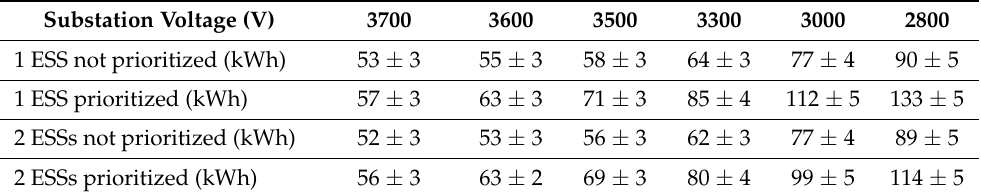
Table 1. Energy dissipated on the line in traction.